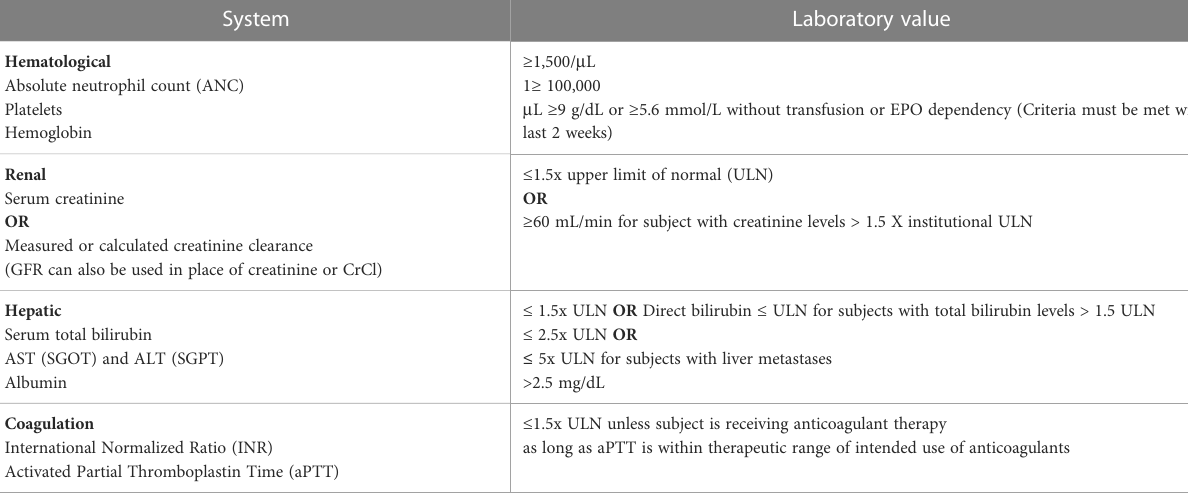
TABLE 1 Adequate organ function laboratory